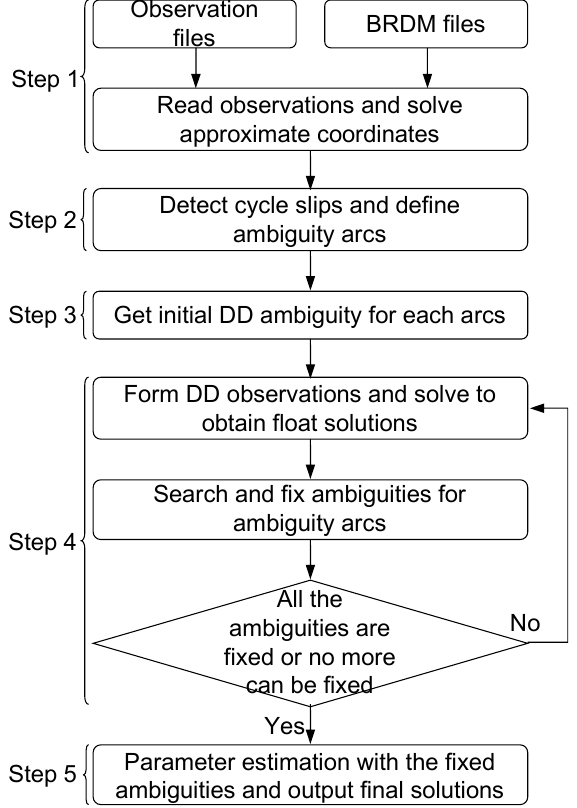
Figure 1. Data processing flowchart.